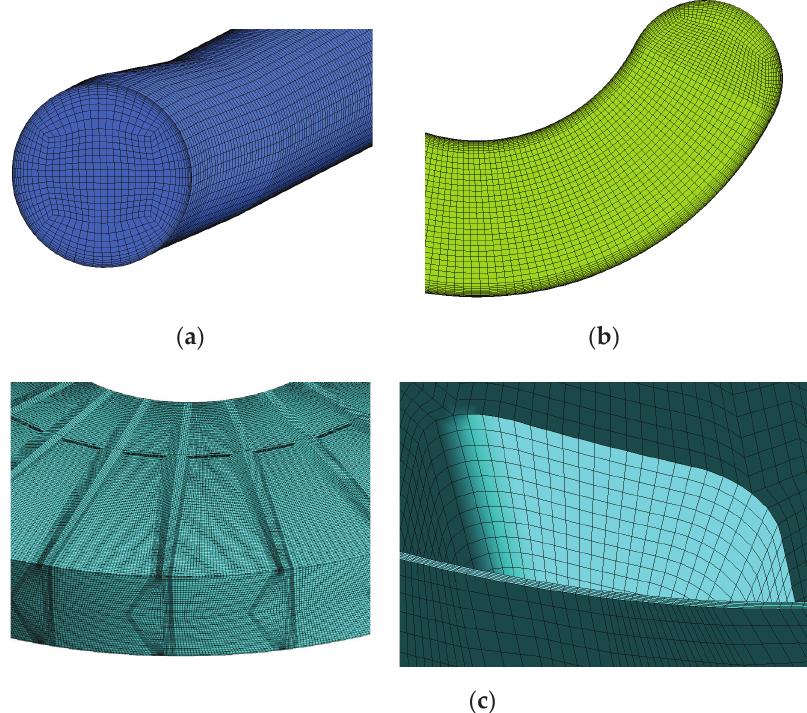
Figure 4. Partial mesh view of the flow domain: ( a ) inlet pipe, ( b ) side channel, ( c ) impeller and gaps.